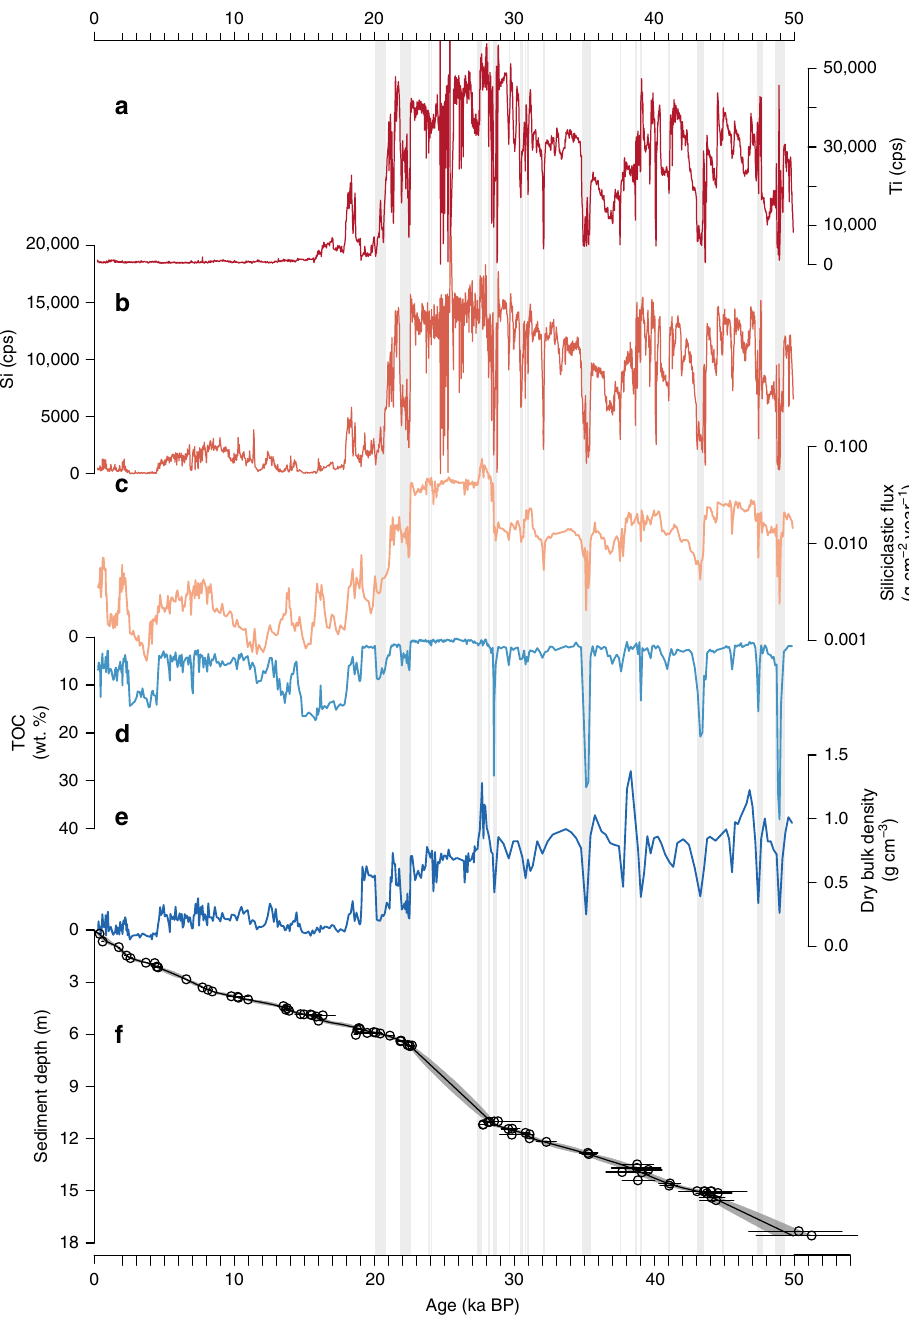
Fig. 2 Physical and geochemical sediment properties from the Junín drill core. The similar XRF pro fi les of a Ti and b Si indicate both elements primarily represent clastic inputs, with slight differences attributable to different bedrock mineralogy and grain size. c Siliciclastic sediment fl ux (log scale). d Total organic carbon (TOC). e Dry bulk density. f Bacon age-depth model of 79 AMS radiocarbon ages on terrestrial macrofossils; error bars denote 95% probability range for calibrated ages. Ages excluded from the age model are listed in the supplemental. Gray vertical bars show the distribution of peat